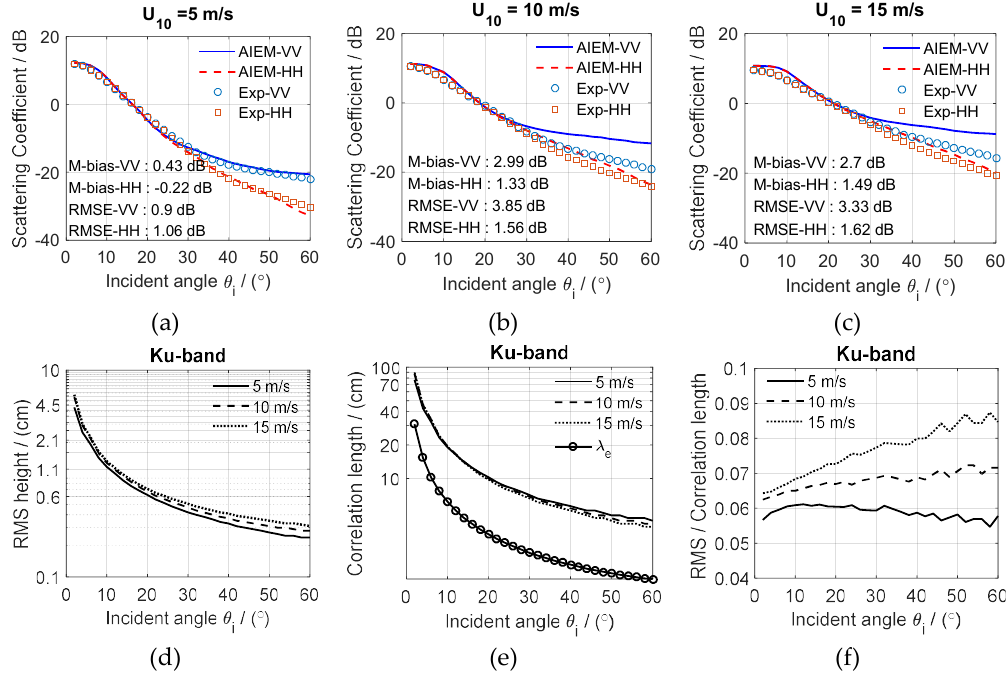
Figure 7. Comparisons of the simulated backscattering based on Apel spectrum for Ku-band with NSCAT-4 model at the wind speeds of ( a ) 5 m/s, ( b ) 10 m/s, and ( c ) 15 m/s; and the corresponding roughness parameters ( d ) RMS height, ( e ) correlation length and effective wavelength (λ e ), and ( f ) the ratio of RMS and correlation length.